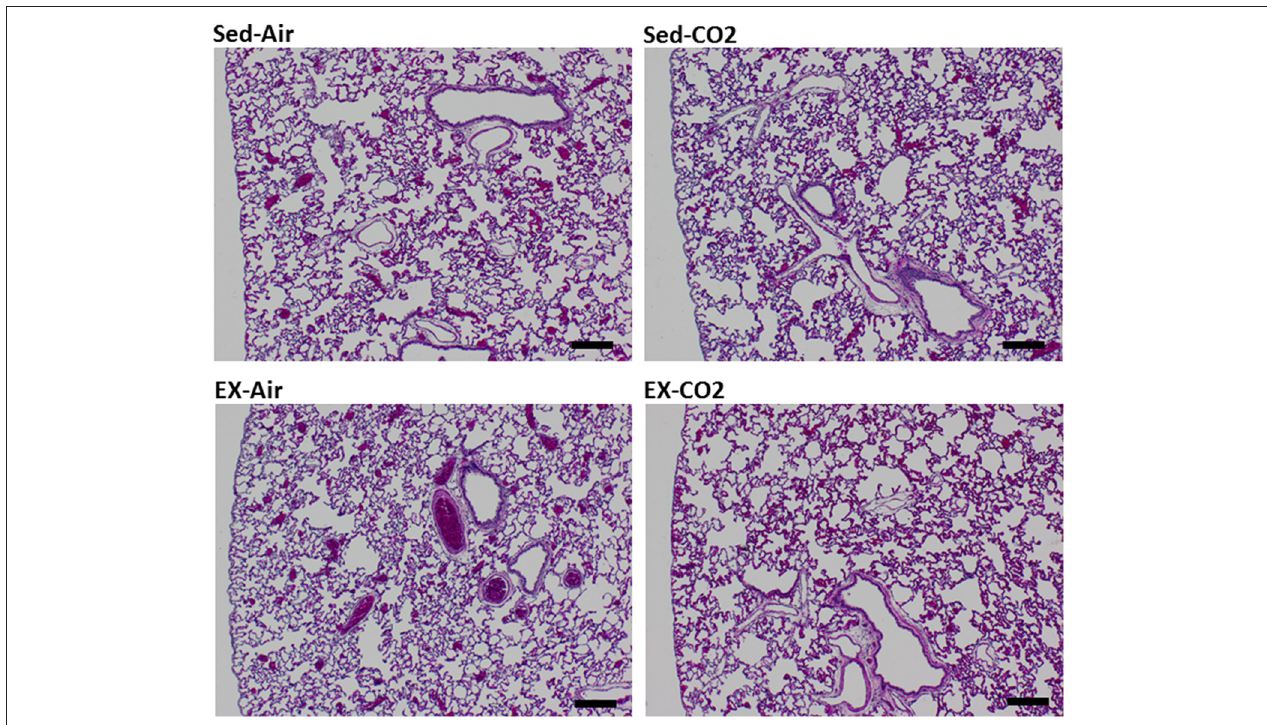
FIGURE 5 | Histology of HH exposed left lung lobe. Representative sections for each treatment group. Tissues were assigned quantitative pathology scores by a veterinary pathologist. Black bar = 200 µ m.